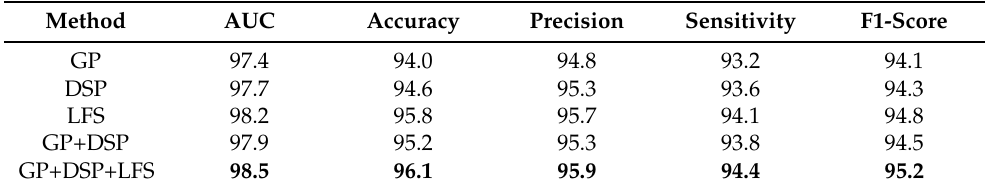
Table 4. Influence of multi-granularity structure.